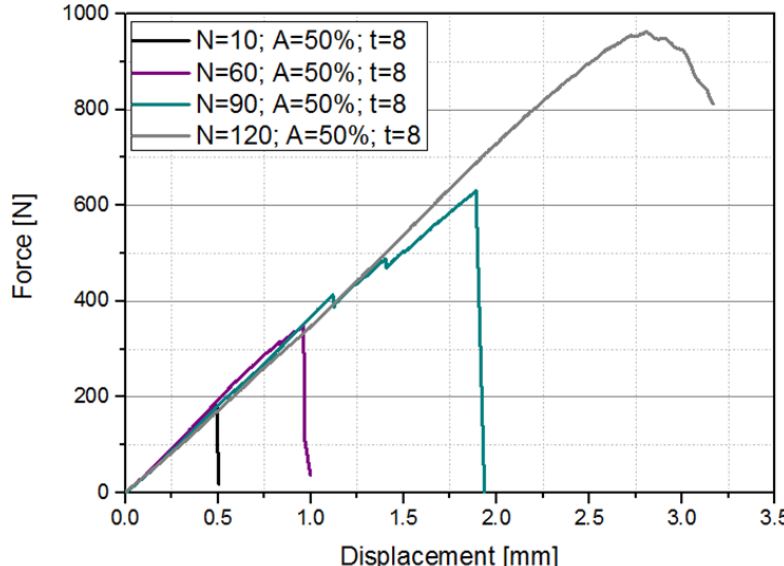
Figure 6. Comparison of the load-carrying capacity of specimens bonded with varying ultrasonic parameters.